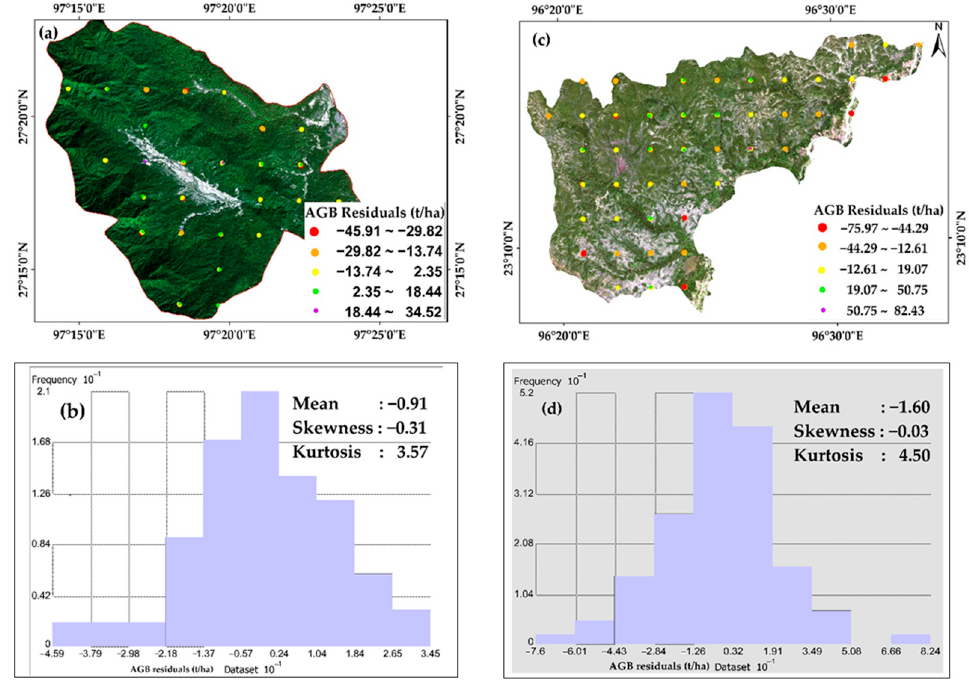
Figure 7. Spatial distributions of the residuals and corresponding frequency histograms; ( a , c ) are RF-based AGB-residuals for NH evergreen and YM deciduous, respectively; ( b , d ) are frequency histograms of AGB-residuals for NH evergreen and YM deciduous, respectively. Table 7. Parameter estimations for the semivariogram analysis based on Gaussian